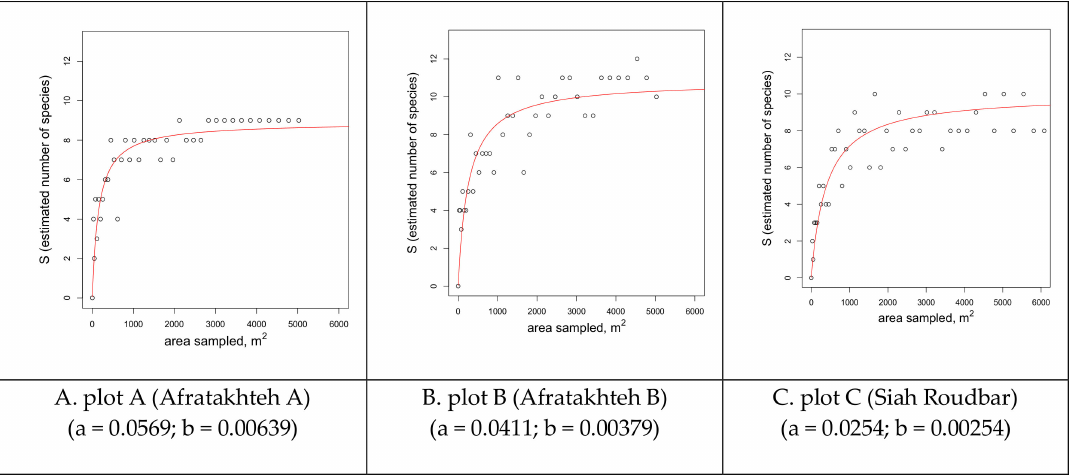
Figure 6. Estimated species–area relations for the three Taxus baccata plots ( A , B , C ); the specific parameters of the Monod model are listed between brackets (see also Table 2).